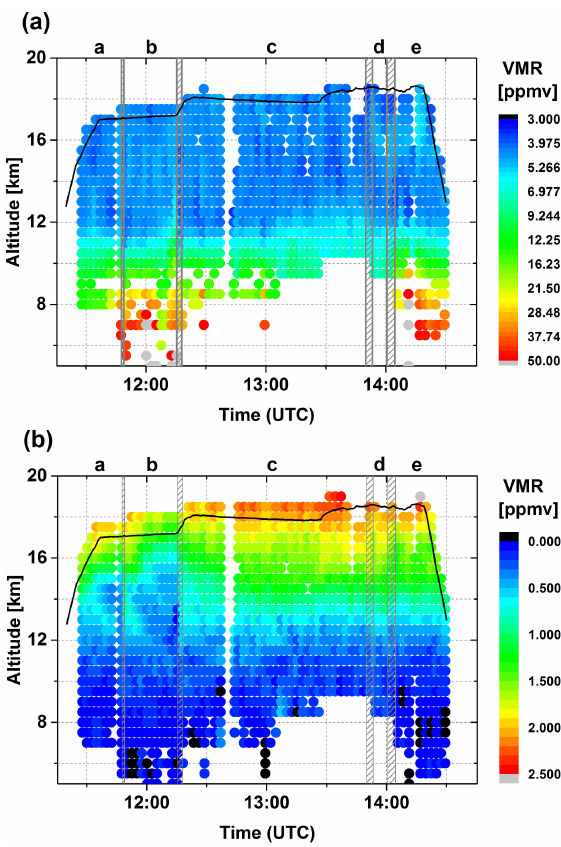
Figure A2. Left panels: vertical profiles of HNO 3 ( g ) , H 2 O ( g ) , and O 3 retrieved from the MIPAS-STR observations during the PSC encounter (grey and black) including initial guess/a priori profiles (yellow; HNO 3 ( g ) and O 3 : Remedios et al., 2007; H 2 O ( g ) : 0ppmv at all altitudes). For H 2 O, collocated FISH total H 2 O ( g + s ) mea- surements during the PSC encounter and the subsequent descent phase are shown for comparison. Right panels: vertical resolutions of MIPAS-STR